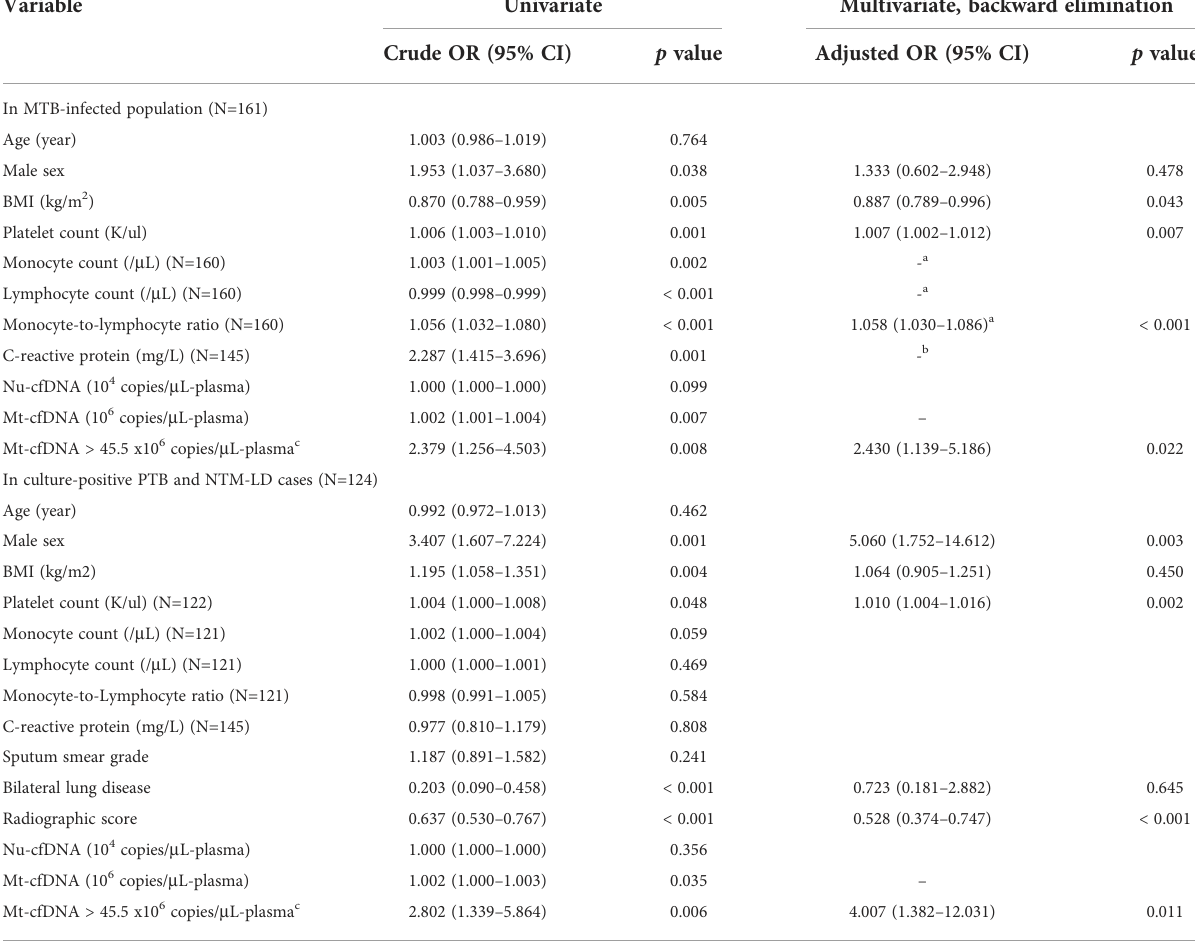
TABLE 2 Logistic regression model of factors associated with the diagnosis of culture-positive pulmonary tuberculosis